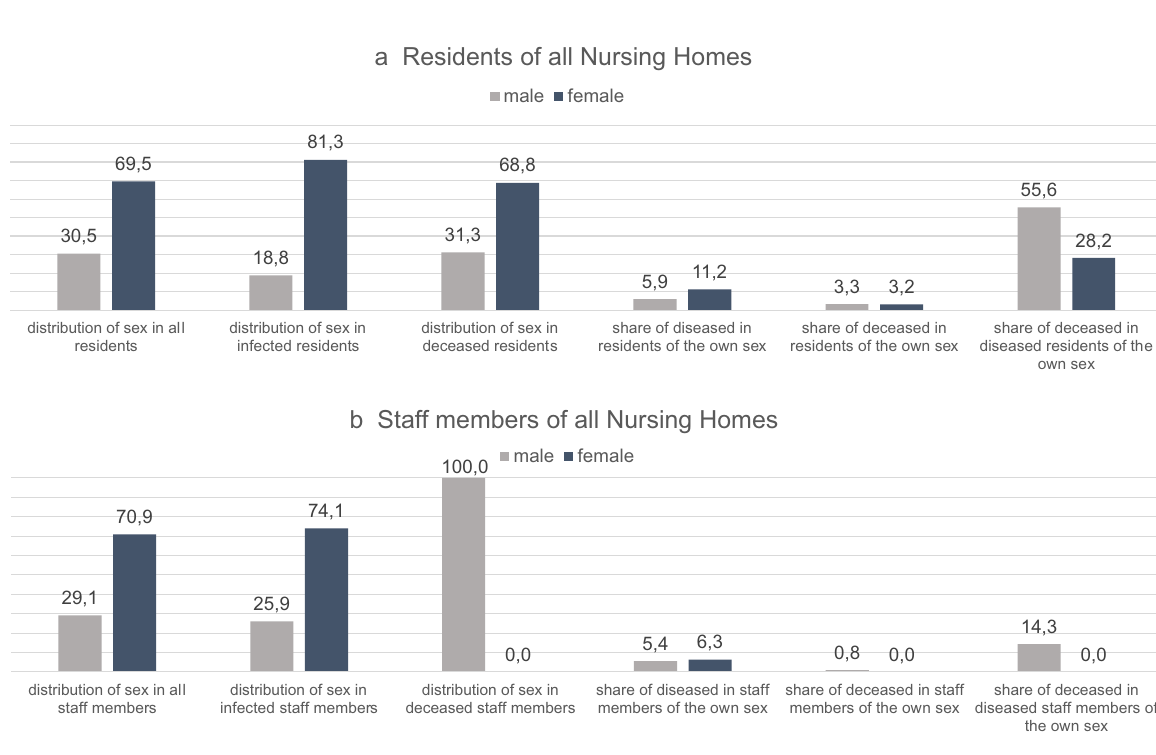
Figure 7. Sex distribution of diseased residents and staff members. ( a ) Residents of all three nursing homes. Data are given in (%). ( b ) Staff of all three nursing homes. Data are given in